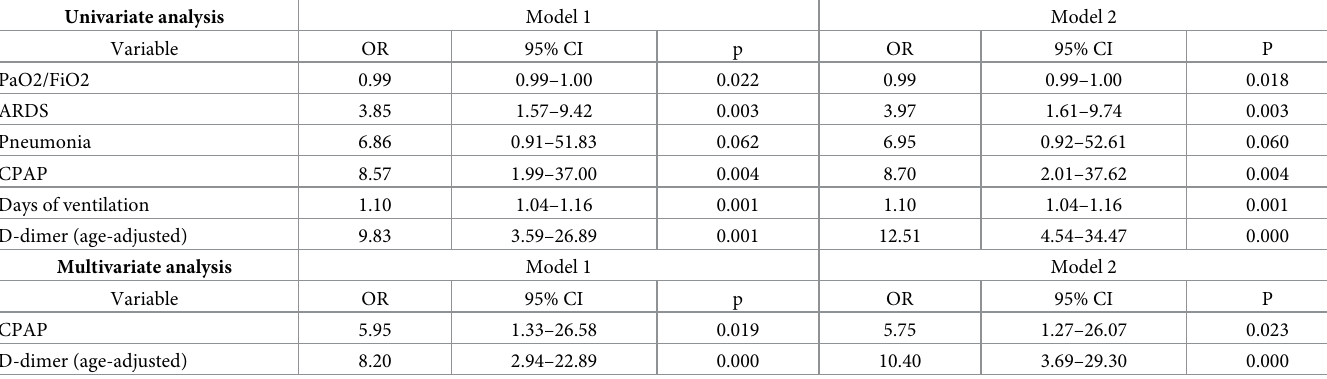
Model 1 represents the comparison between patients with UEDVT and patients without UEDVT; model 2 represents the comparison between patients with UEDVT and patients without